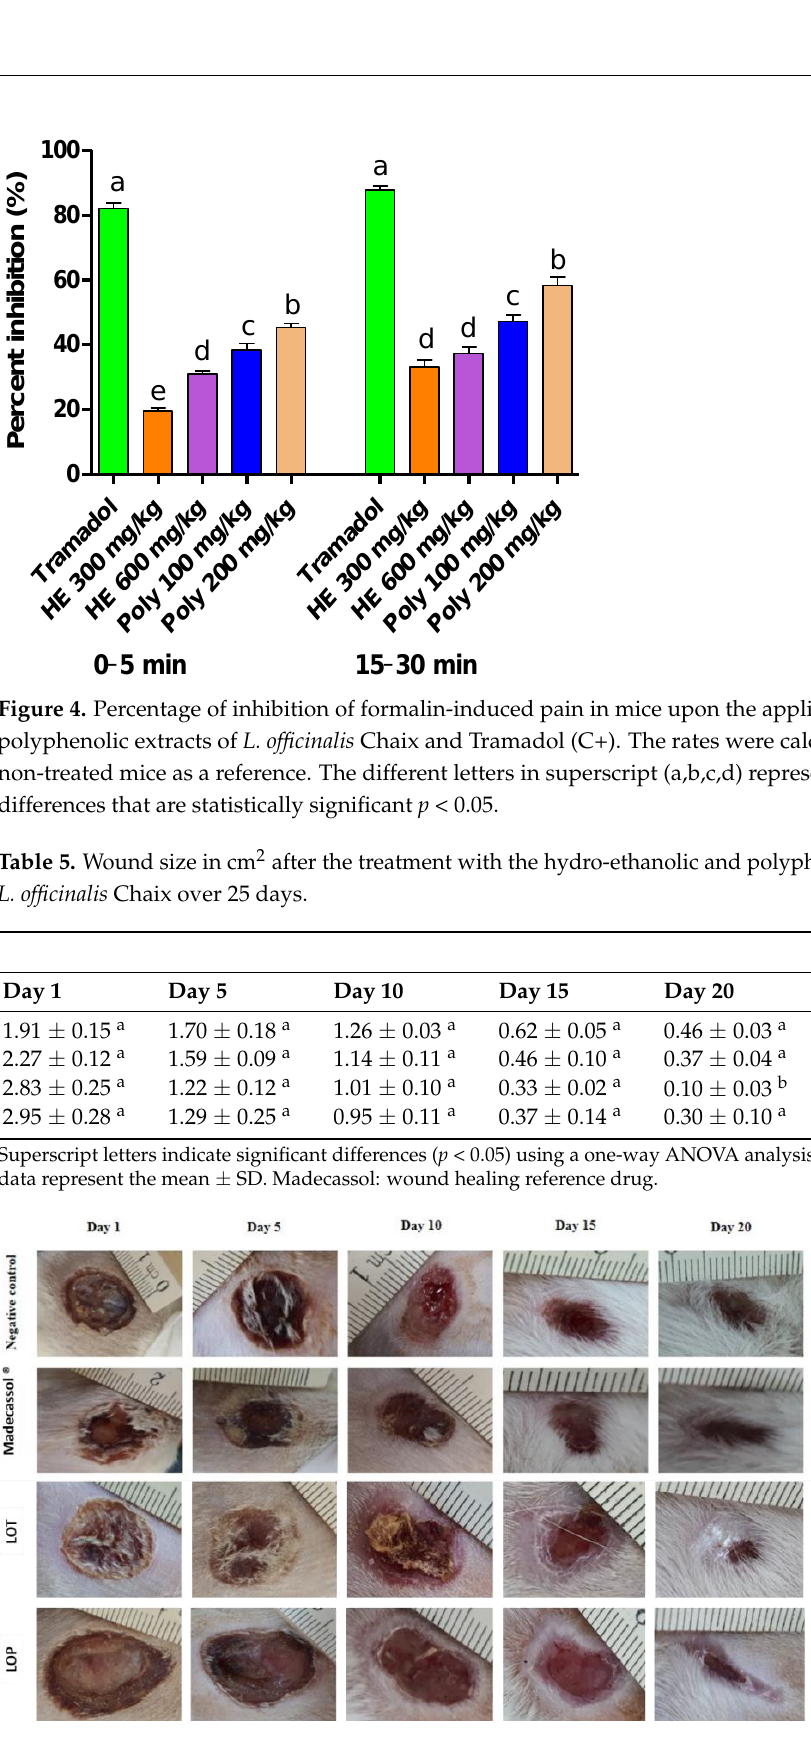
Figure 5. Photographic representation and morphological aspects of the burn-healing process using the hydro-ethanolic (LOT) and polyphenolic (LOP) extracts of L. officinalis Chaix and the control groups from day 1 to day 25.